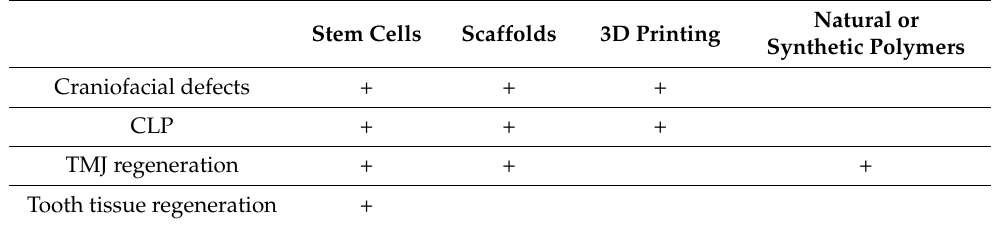
Natural 3D Printing